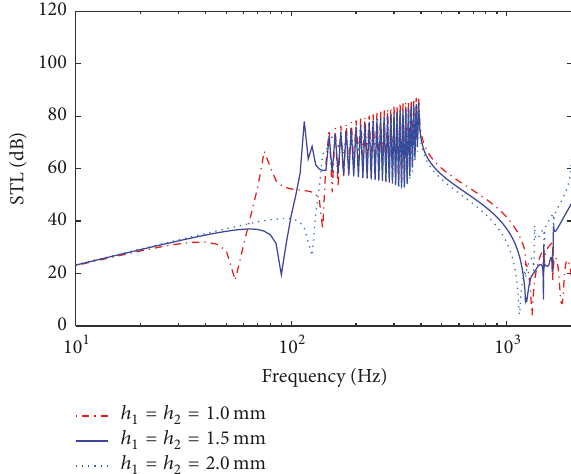
Figure 13: STLs of the research structure under the condition of having selecting rib-stiffener spacing. Figure 14: STLs of the research structure under the condition of having selecting facesheet